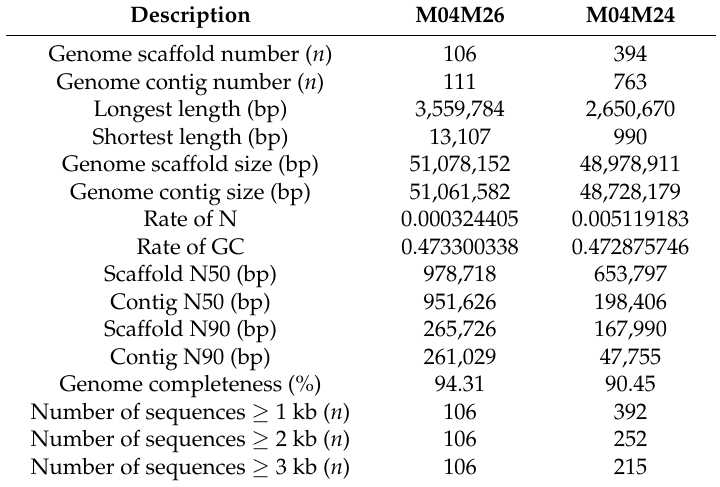
Table 1. De novo genomic assembly results of the two opposite-polarity monospores of Morchella importuna